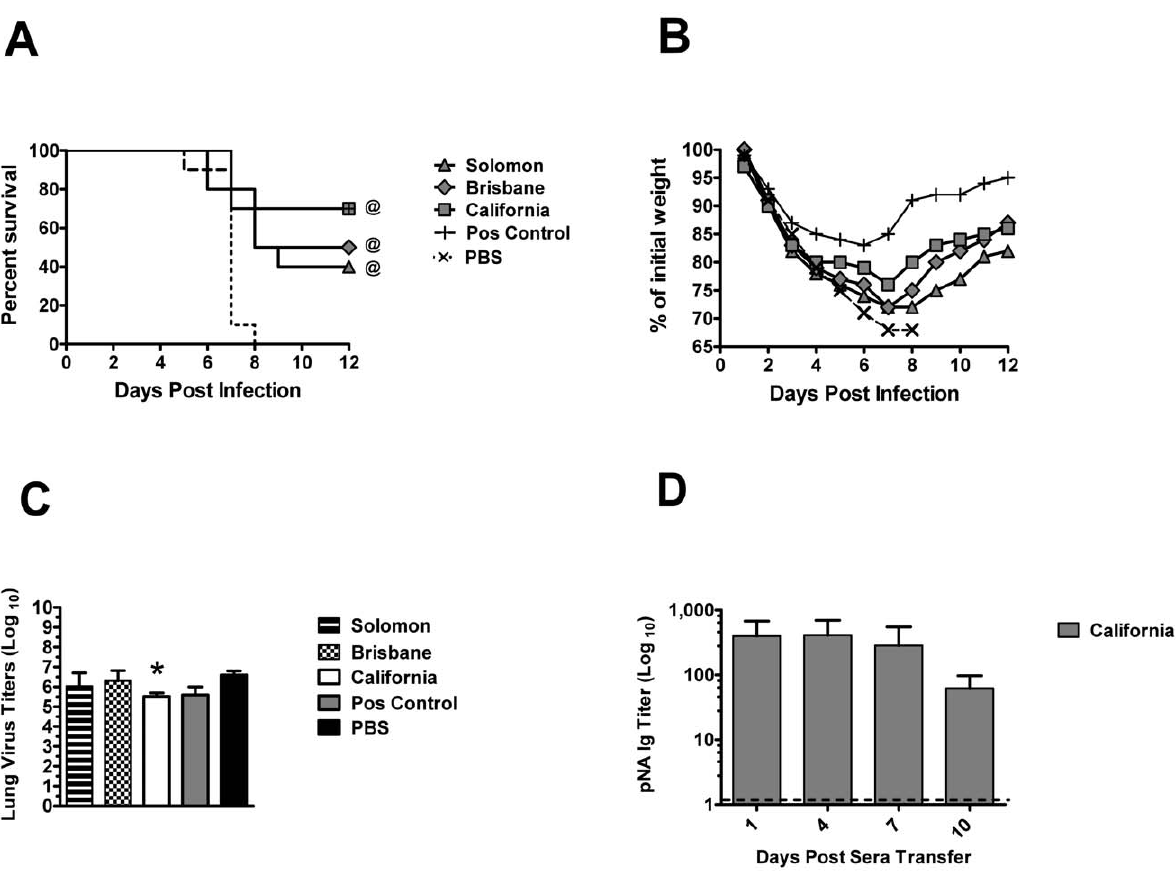
Figure 3. The effect of N1NA antibodies on immunity to pandemic H1N1 2009 challenge. Naı¨ve Balb/c mice were injected intraperitoneally with pooled convalescent sera collected from mice infected with 7 + 1 rg recombinant viruses. Control mice were injected with either sera from mice inoculated with PBS or wt California. All passively transferred mice were challenged with a lethal dose (10 6 EID 50 ) of wt pH1N1 virus. Survival, weight loss and virus titers were monitored post challenge. A) Percent survival was measured between animals daily for 12 days post virus challenge; differences between rg California and PBS: P , 0.001. Comparison between rg Solomon or rg Brisbane to PBS: P , 0.02. B) Average weight loss in each treated group after virus challenge was monitored daily for 12 days. C) Virus titers in the lungs of all challenged mice at 5 dpi assessed by TCID 50 . The persistence of passively transferred antibodies in the blood stream was assessed using antibody-deficient SCID mice. Titers of cross-reactive antibodies to pNA-ecto were determined by ELISA. D) Differences in total Ig (IgM, IgA, IgG) titers were measured in the serum of SCID mice at 1 ( P =0.03), 4 ( P =0.03), 7 ( P =0.10) and 10 ( P =0.02) days post passive transfer with rg California. Data is representative of two independent experiments.